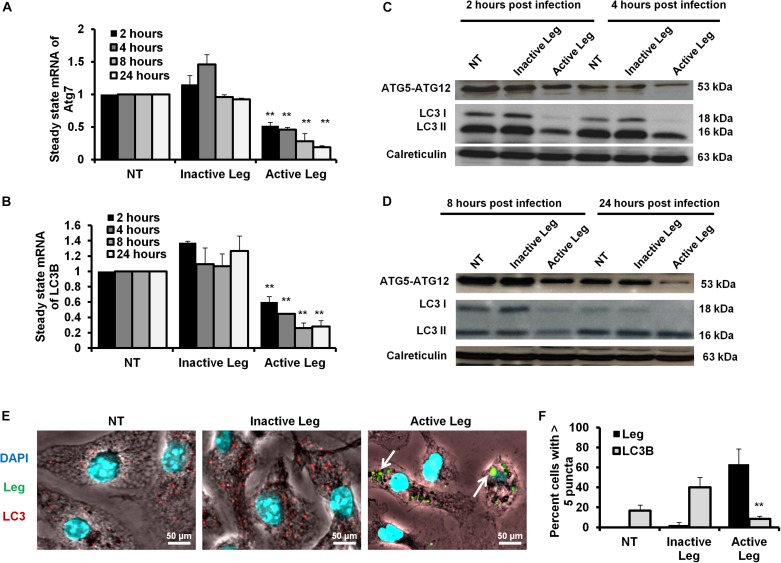
Depletion of autophagosome formation in response to Legionella infection. (A) The fold change in steady-state mRNA of autophagy Atg7 during the indicated time points upon Legionella infection of mice-derived macrophages compared with control-infected cells. (B) Fold change in steady-state mRNA of LC3B in Legionella-infected macrophages related to control-infected cells during the indicated time points. GAPDH-mRNA was used as an internal control for the qRT-PCR test. (C,D) Immunoblotting assays indicate Atg5–Atg12 protein complex, LC3-I, and LC3-II in infected macrophages for different time points compared with control-infected cells. Calreticulin served as an internal control. (E) Immunofluorescent assay represents accumulated LC3B protein (red) and Legionella protein biomarker (green) in mice-derived macrophages in response to Legionella infection. 4′,6-Diamidino-2-phenylindole, dihydrochloride (DAPI) was used for chromosome counterstaining (blue). (F) Scoring of the percentage of macrophages harboring more than five puncta in infected cells compared with other control cells using ImageJ software. Data are representative of 500 cells. Error panels shown represent three independent experiments displaying similar results. Comparison of groups for statistical differences was done using two-tailed Student t test. ∗P ≤ 0.05 and ∗∗P ≤ 0.01.